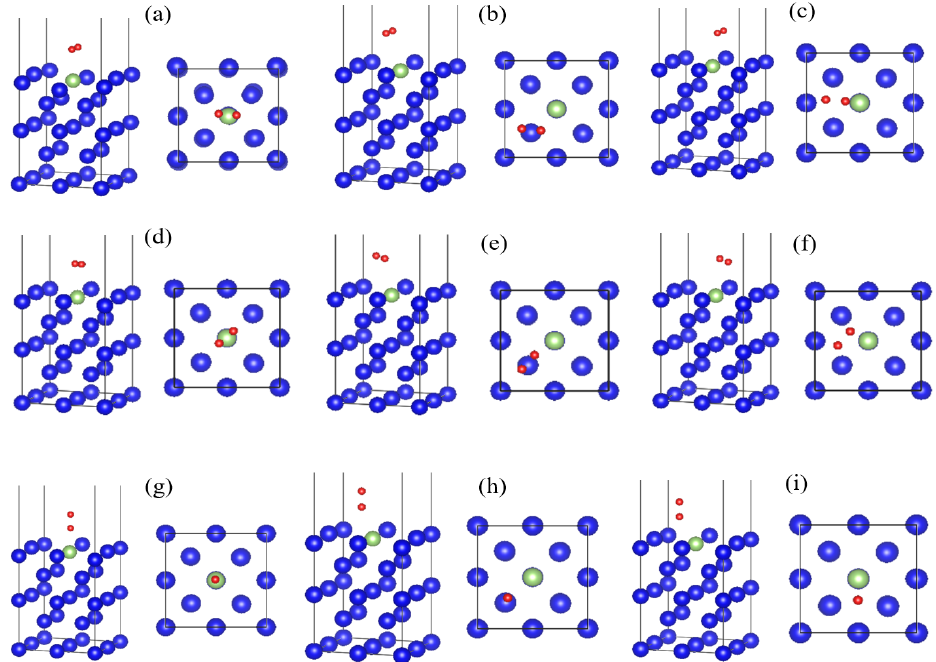
Figure 2. Different initial adsorption configurations of O 2 on the surface of plutonium gallium system: ( a ) O-t-hor1, ( b ) O-h-hor1, ( c ) O-b-hor1, ( d ) O-t-hor2, ( e ) O-h-hor2, ( f ) O-b-hor2, ( g ) O-t-ver, ( h ) O-h-ver, ( i ) O-b-ver. (O: oxygen molecule; t: top position; h: heart position; b: bridge position. The red sphere is oxygen.)